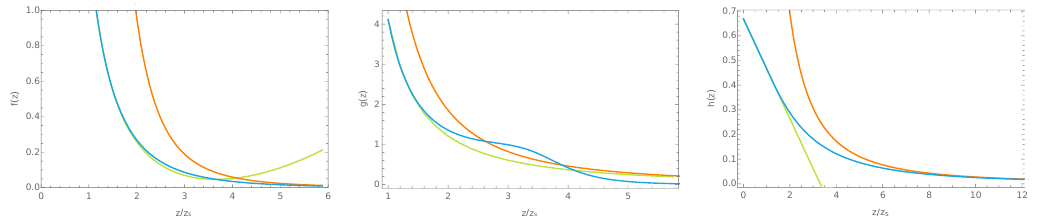
Figure 3 . We plot the electron star background functions f , g and h vs. z/z s (light blue line), compared to the Lifshitz solution (orange) and AdS Reissner-Nördstrom black hole (light green) respectively. The parameters are chosen as ˆ m = 0 . 4 and λ = 2